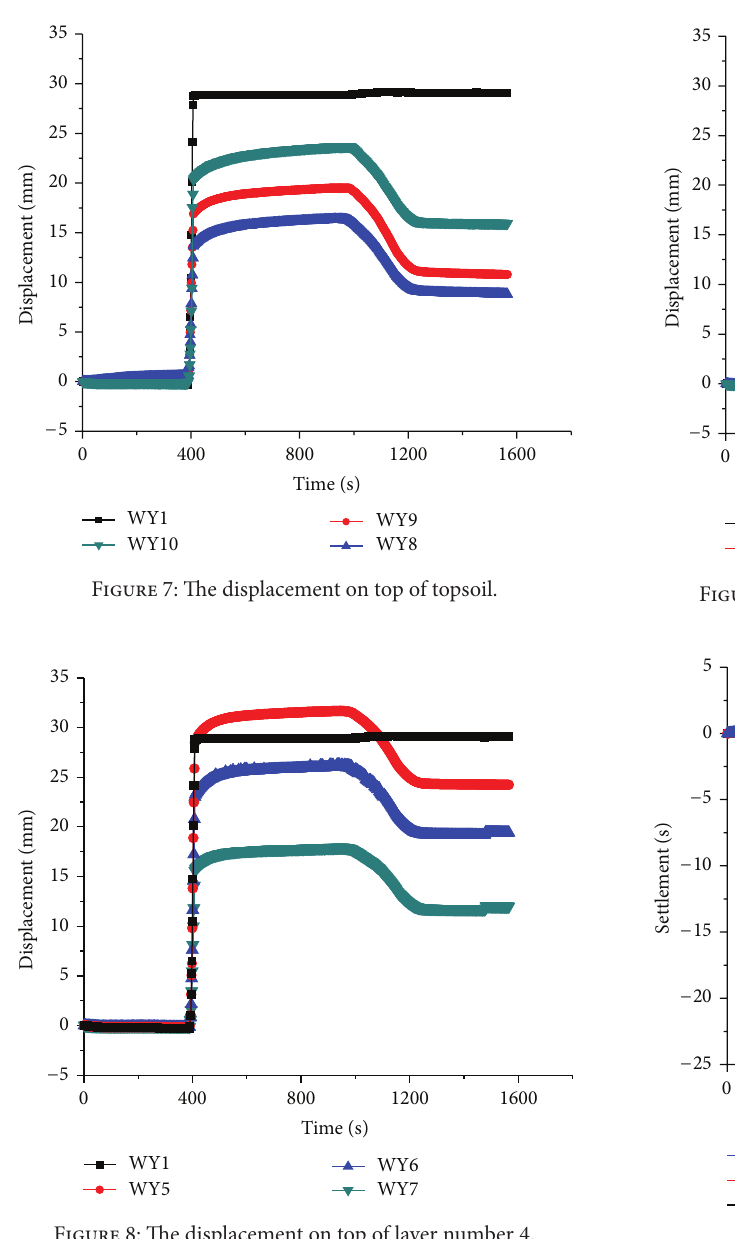
Figure 10: The settlement of layer number